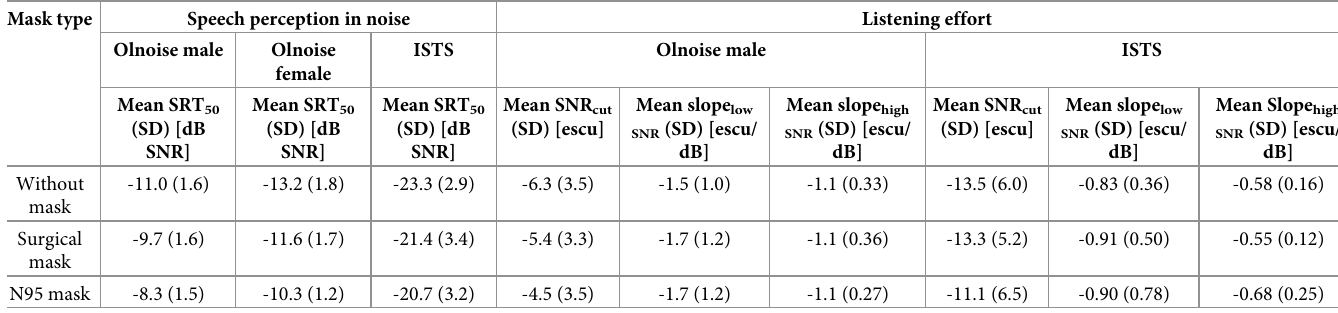
Table 1. Speech perception in noise and listening effort results.